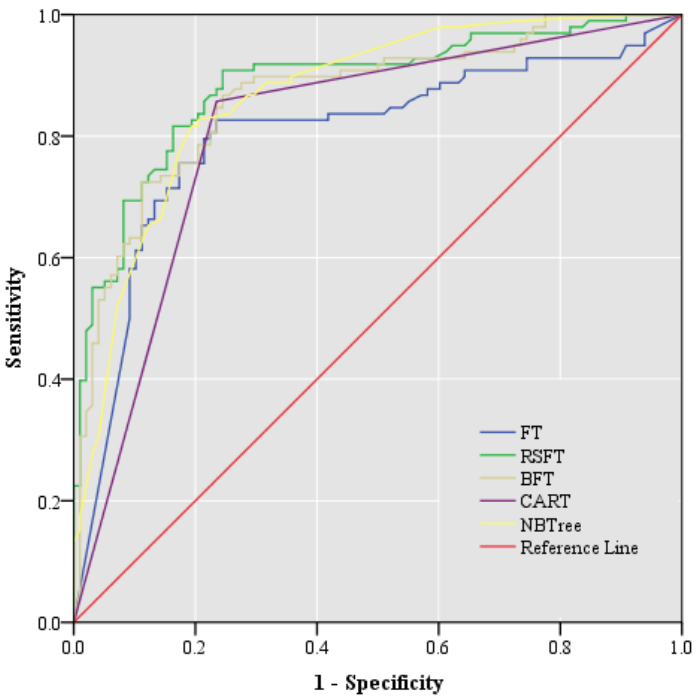
Figure 6. ROC curves of the models using validation dataset. Table 2. Model validation.